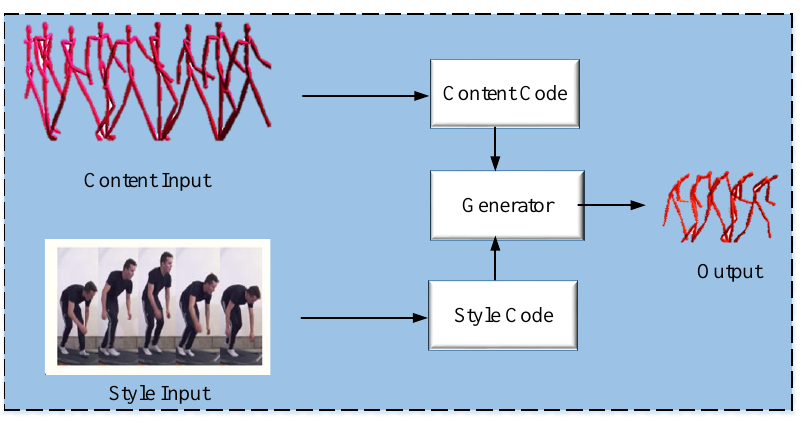
Figure 4. Motion style transfer from video